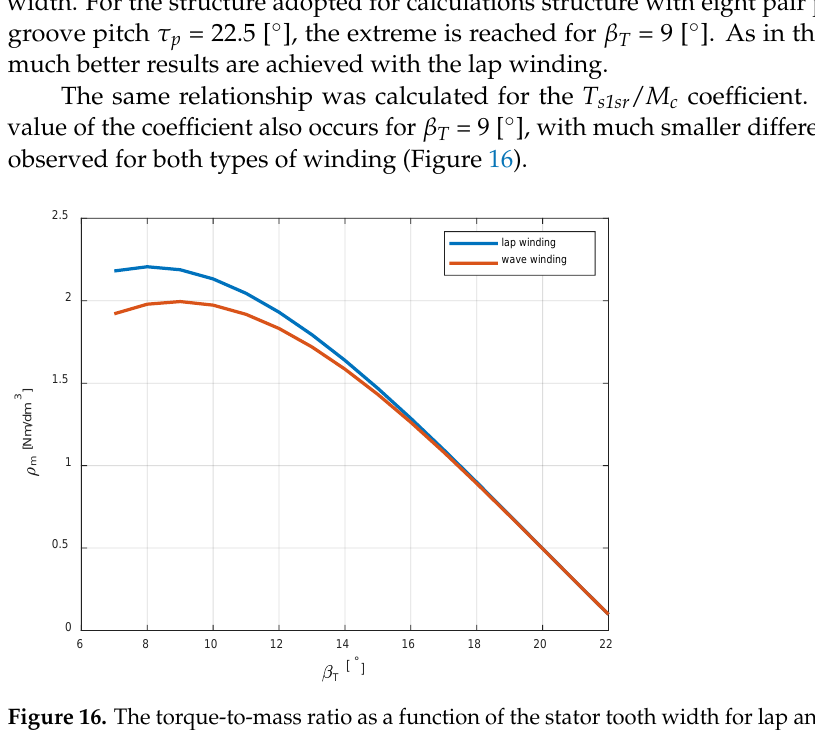
Figure 16. The torque-to-mass ratio as a function of the stator tooth width for lap and wave wind- ings.